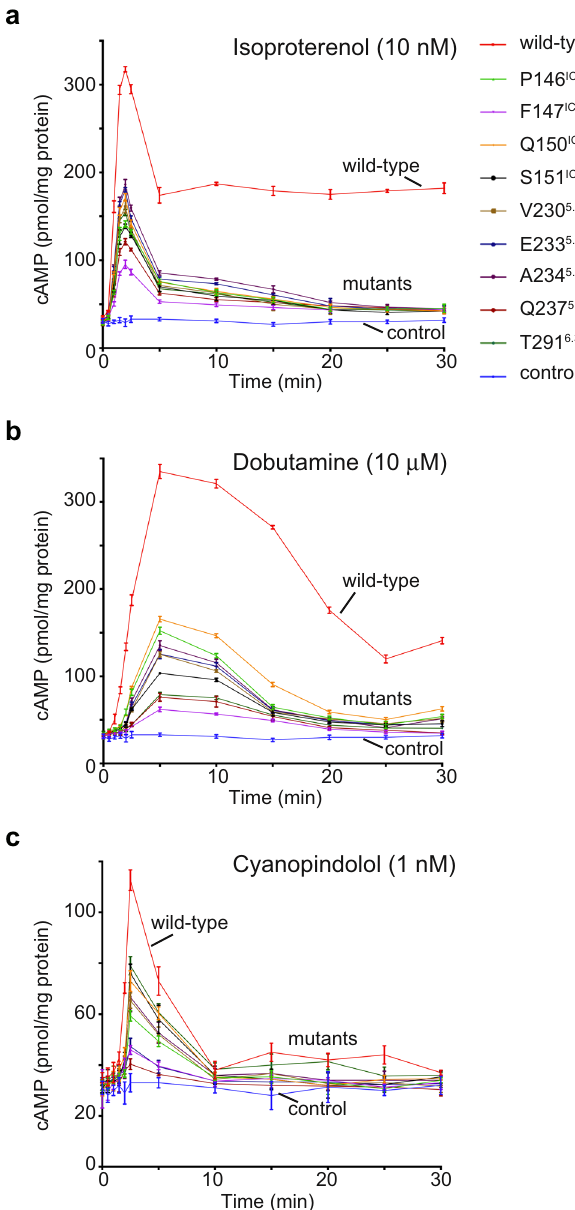
Fig. 6 Effects of β 1 -AR mutations on the time-dependent cellular cAMP responses initiated by three different ligands. Time-dependent cAMP responses induced by isoproterenol ( a ), dobutamine ( b ), or cyanopindolol ( c ), are decreased by the β 1 -AR mutations. Data are presented as mean ± SD of three experiments. When comparing with the wild-type receptor, all mutant receptors showed signi fi cant difference with p values <0.05 (Student ’ s t -test, two-sided). The color keys for the receptor mutants are displayed in ( a ), and are the same for ( a , b , and c ). Source data are provided as a Source Data fi le.